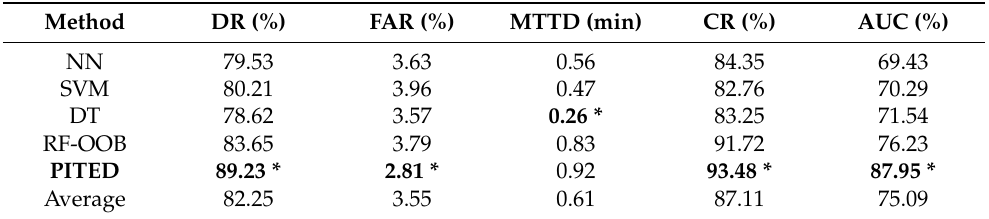
Table 3. Comparison of evaluation indicators by different methods (* bold is the optimal